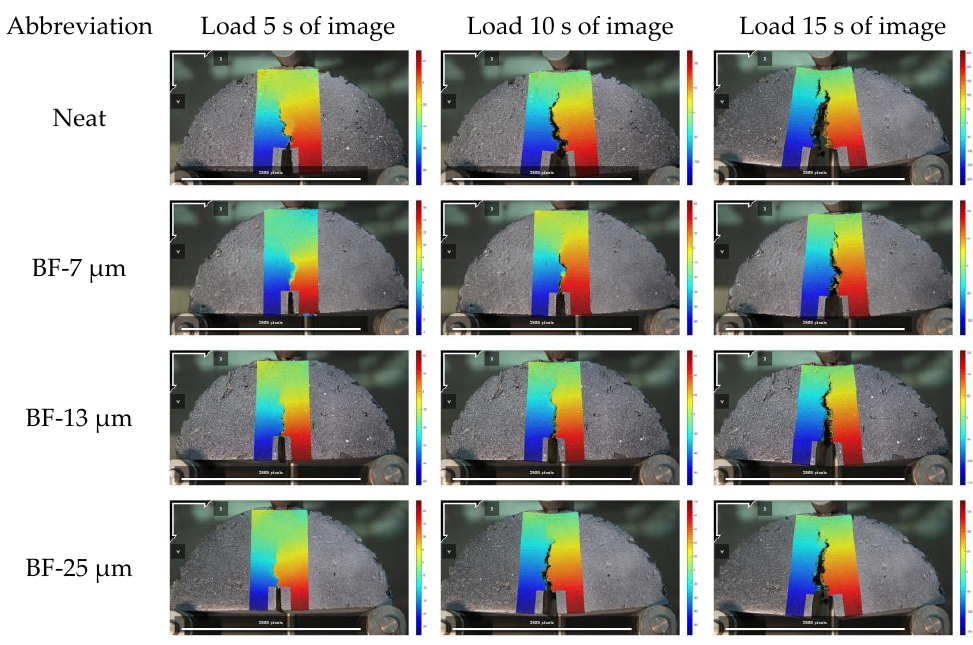
Figure 14. Horizontal displacement cloud pictures.